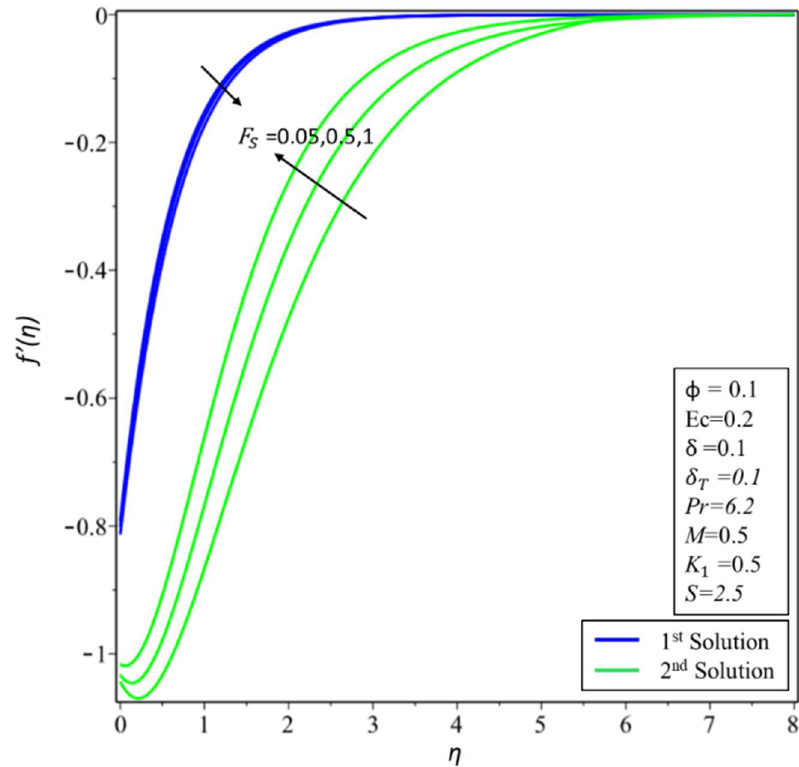
Figure 12. Changes of f (cid:48) ( η ) for F s .